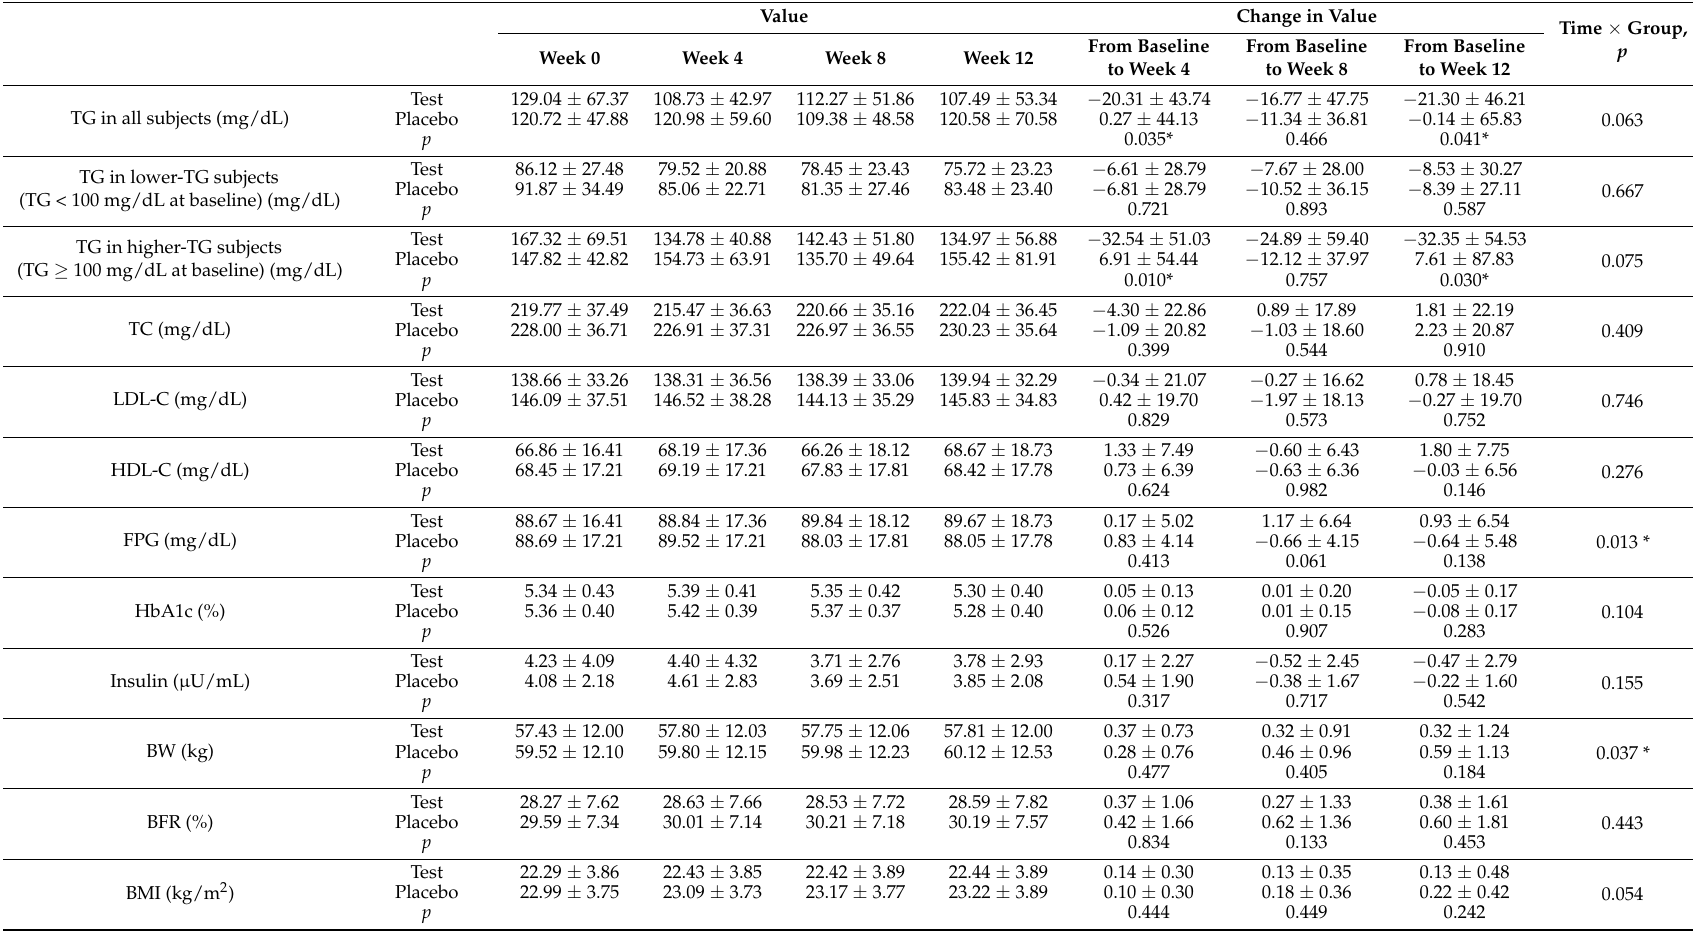
Table 3. Lipid metabolism parameters, blood glucose metabolism parameters, and body